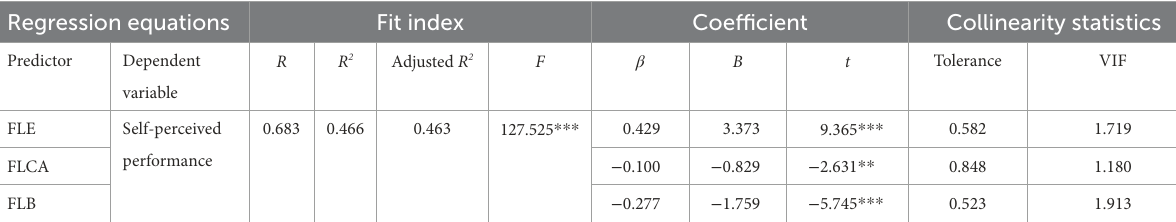
TABLE 8 Regression analysis with three emotions as predictors of self-perceived performance for reading-and-writing group. Regression equations